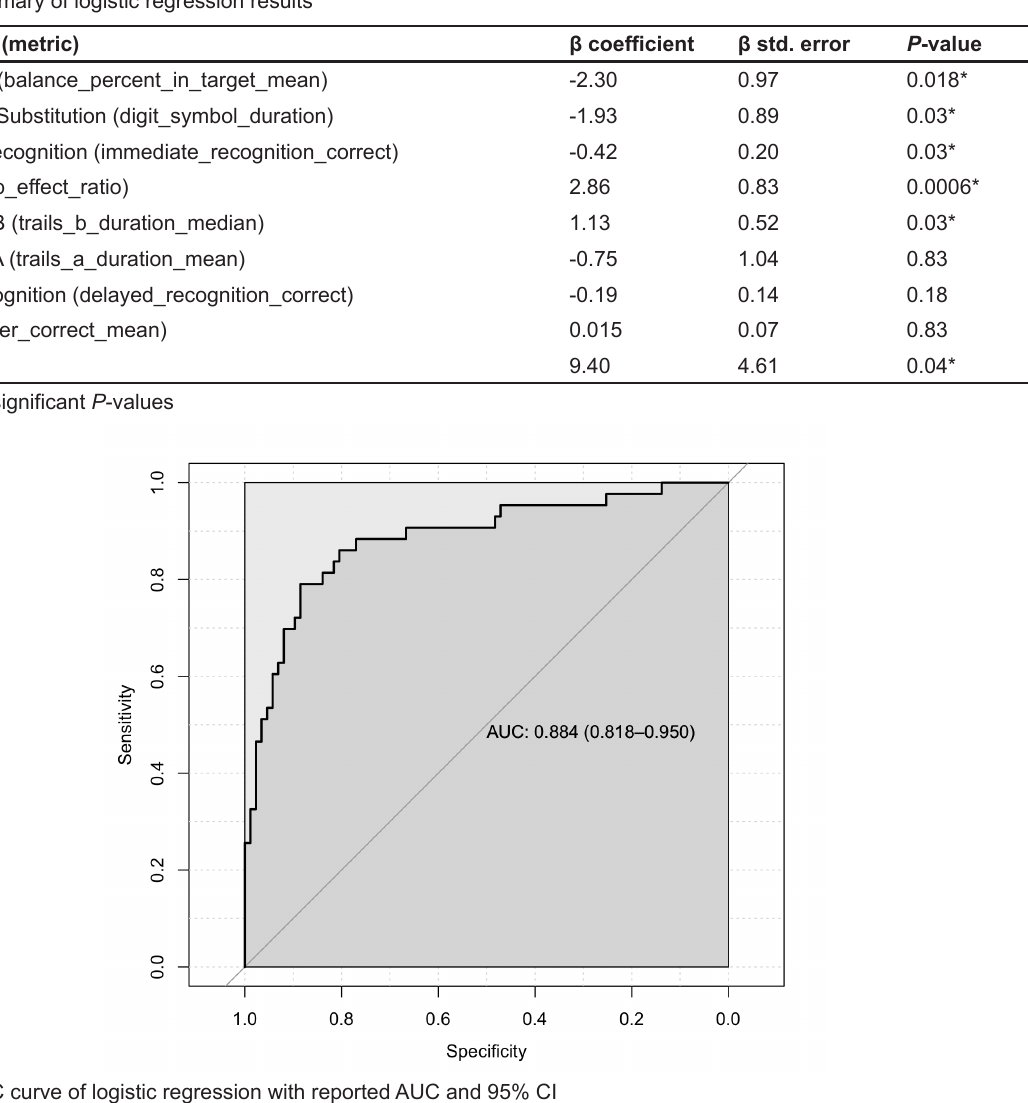
Figure 4. ROC curve of logistic regression with reported AUC and 95%